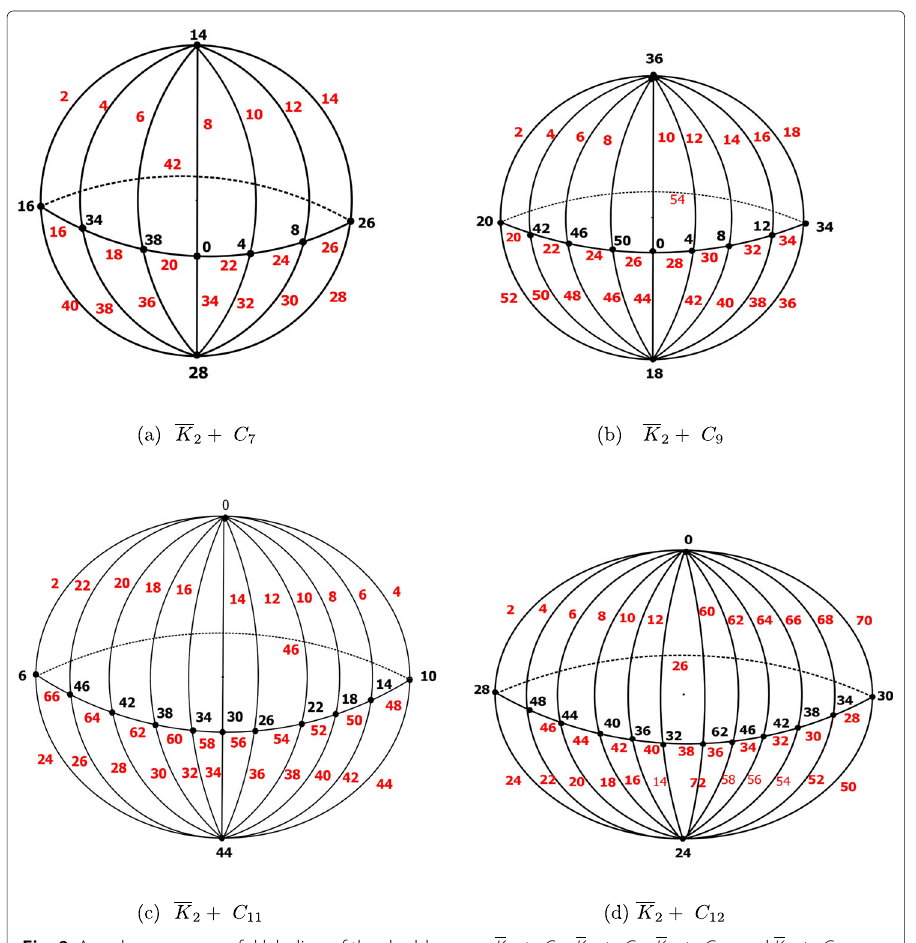
Fig. 9 An edge even graceful labeling of the double cones K 2 + C 7 , K 2 + C 9 , K 2 + C 11 , and K 2 + C